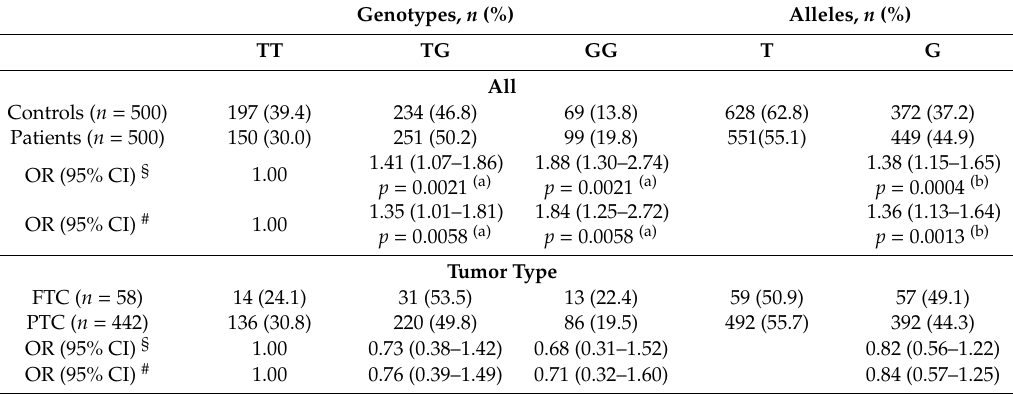
Table 1. Analysis of DHCR7 rs12785878 genotype and allele